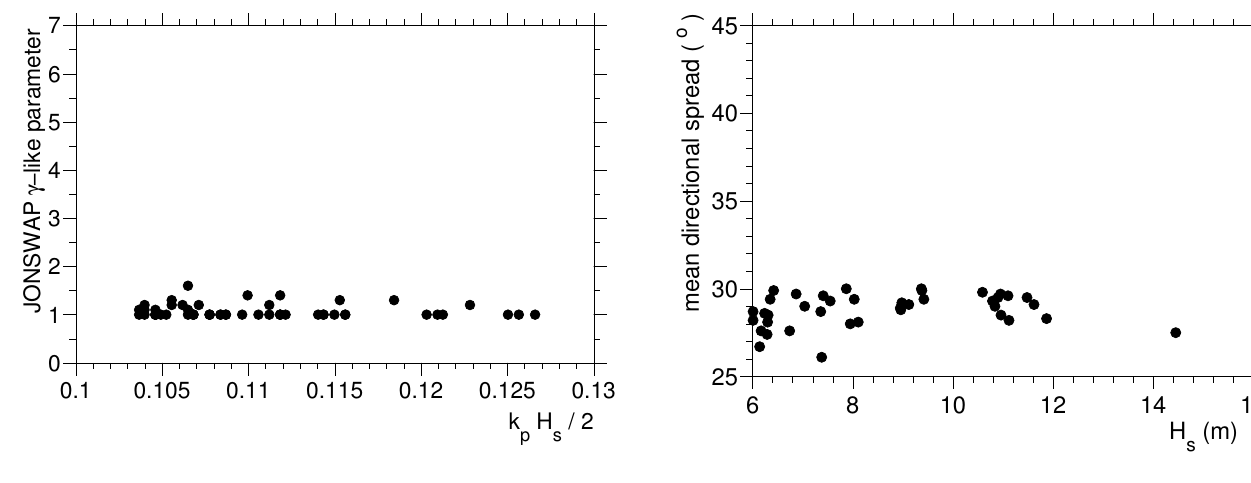
Fig. 4. Mean directional spread for events with H s > 6m and ka > 0.1 (Oceanweather Inc.